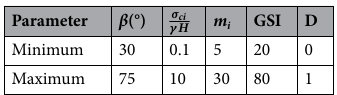
Table 1. Range of slope parameters.